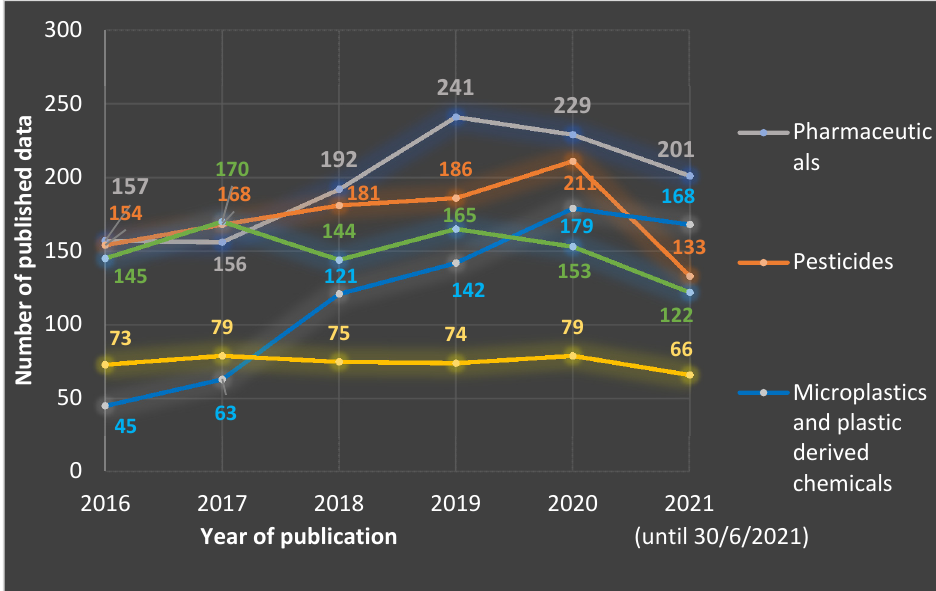
Figure 3. Annual number of records published for each selected chemical group of POPs and potential effects on marine biota. The plotted data were obtained from “Scopus”, “Google Scholar”, “SpringerLink”, and “Open Access Journal Search Engine”. Overall means all kinds of data including research article, review, short notes, editorial commentary, research articles, books and book chapters, etc., that were published from 1 January 2016 to 30 June 2021. Target pollutants were tested either individually or in mixture with other contaminants.